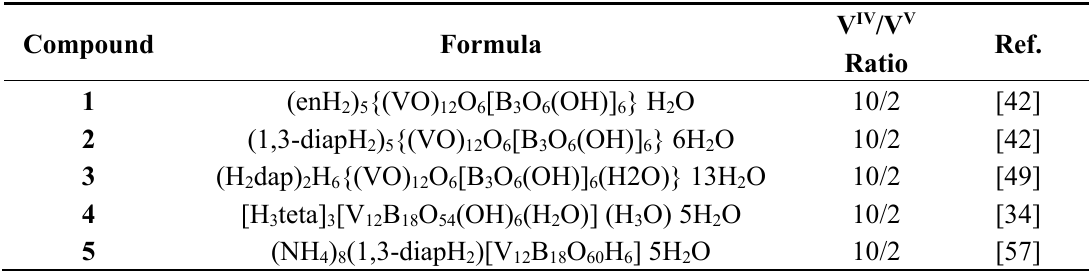
Table 1. List of the lattices with protonated amines as counterbalancing ions. The mixed valence V IV /V V ratio is indicated for each